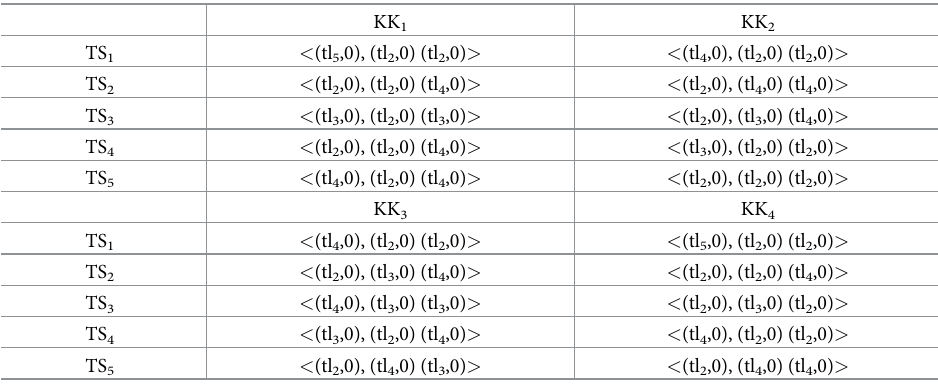
Table 1. 2TLNNs decision